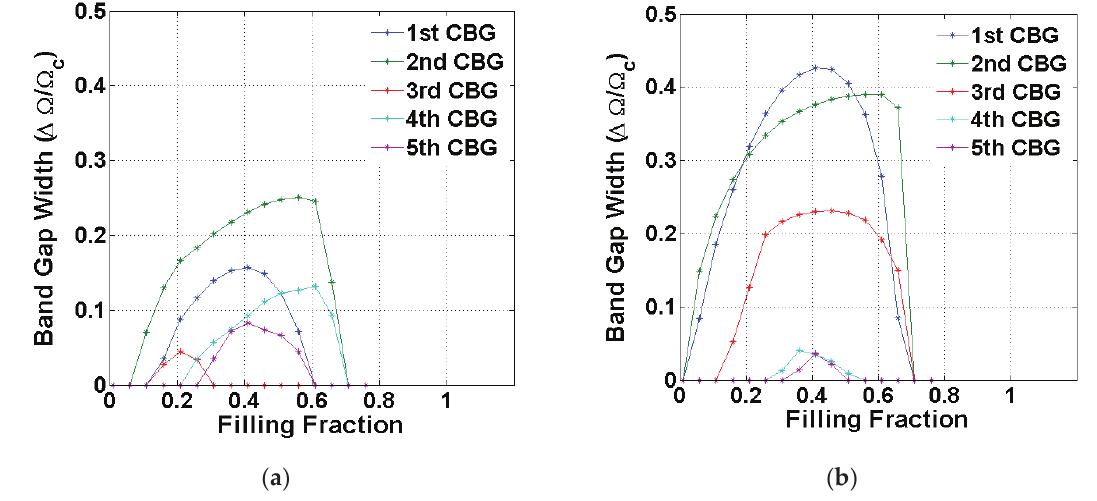
Figure 4. Complete band gap widths of the MPnC with circular scatterers and Kagomé lattice, considering XY modes ( a ) and Z modes without piezoelectric and piezomagnetic effects ( b ).